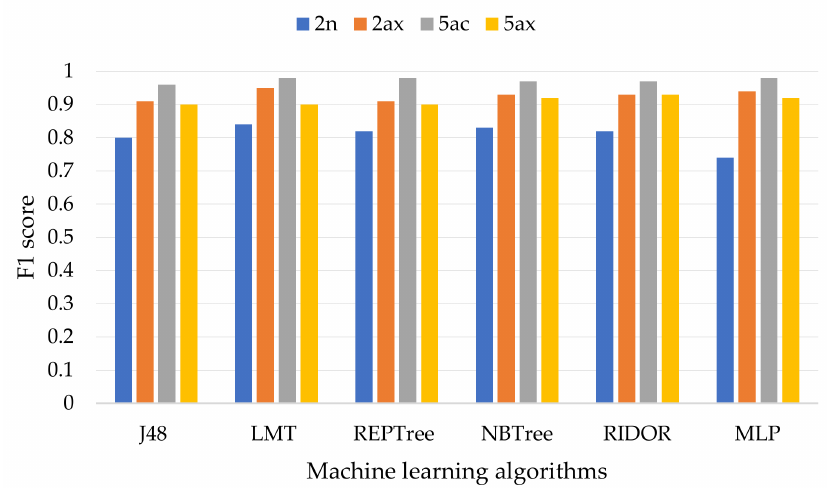
Figure 3. The F1 score of candidate ML algorithms testing 30% of